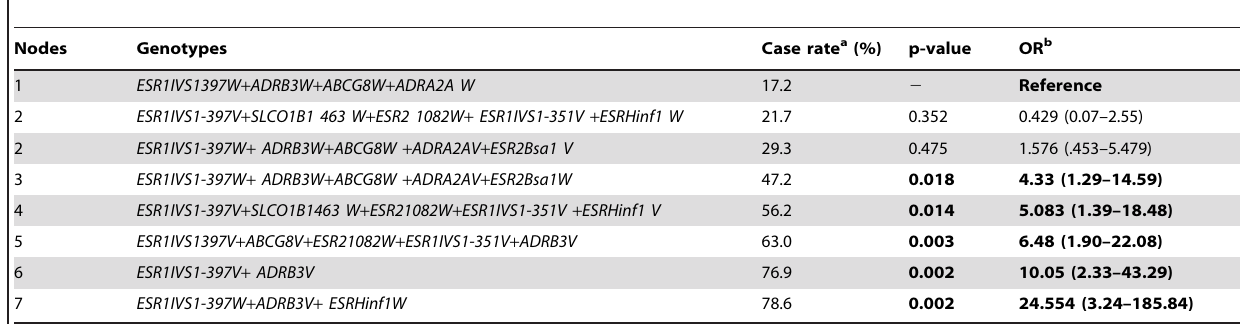
Table 7. Risk Estimates of CART Terminal